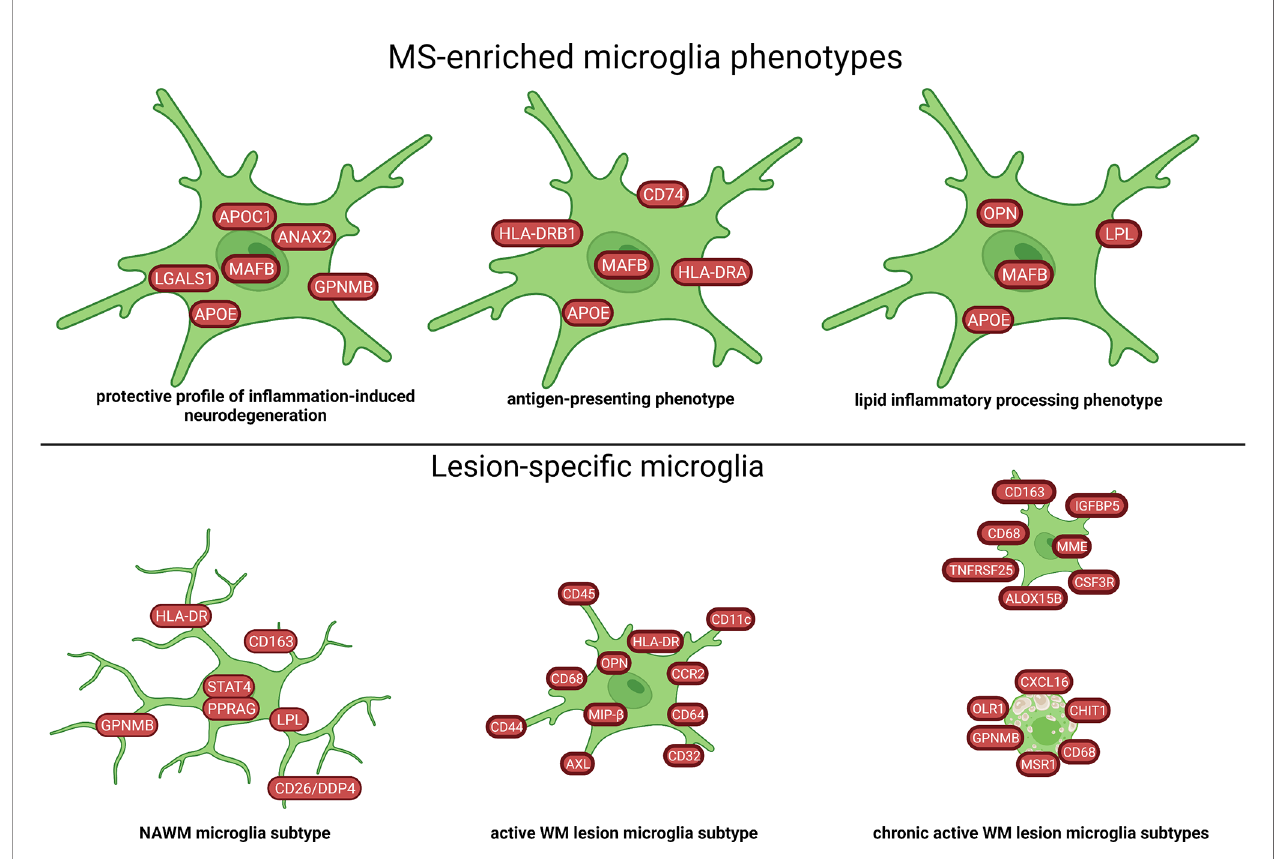
FIGURE 8 | Signature of microglia subtypes in the WM of MS brain based on transcriptome and proteome studies. Different pro fi les of microglia in WM tissue of MS have been identi fi ed. The NAWM microglia subtype in the fi gure was created by compiling data from several articles, and therefore molecules may not be expressed at the same time. Created with